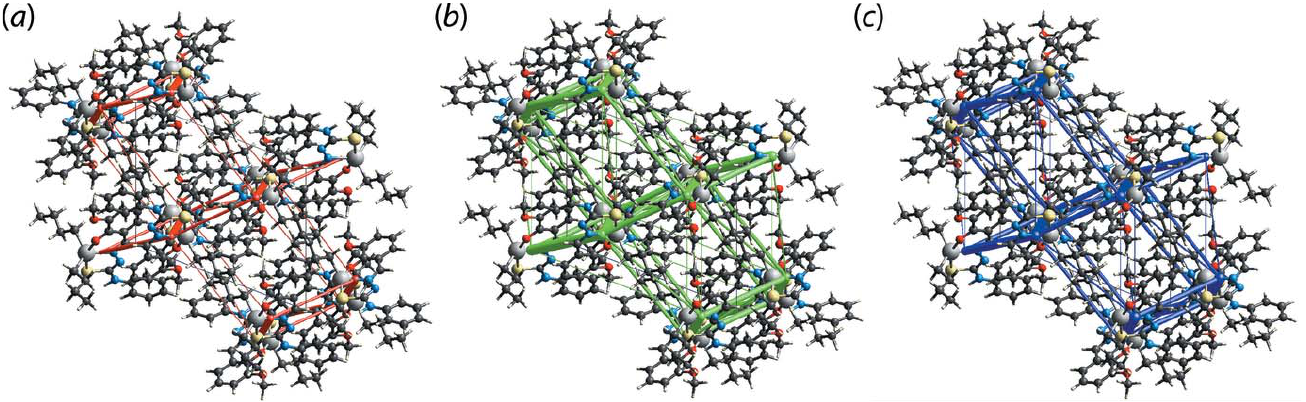
Figure 7 Perspective views of the energy frameworks calculated for (I) showing ( a ) electrostatic potential force, ( b ) dispersion force and ( c ) total energy, each plotted down the b axis. The radii of the cylinders are proportional to the relative magnitudes of the corresponding energies and were adjusted to the same scale factor of 55 with a cut-off value of 5 kJ mol (cid:6) 1